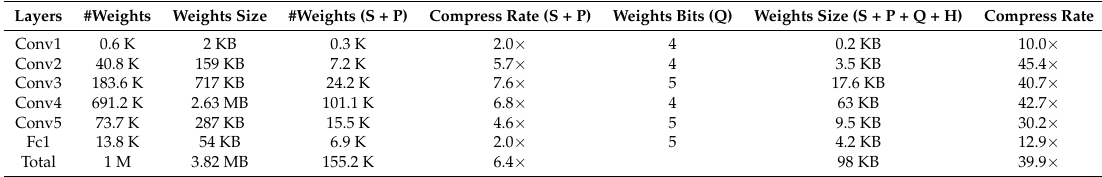
Table 4. Compression statistics in SOC 3-class experiment. S: squeezing, P: pruning, Q: quantization, H: huffman coding.